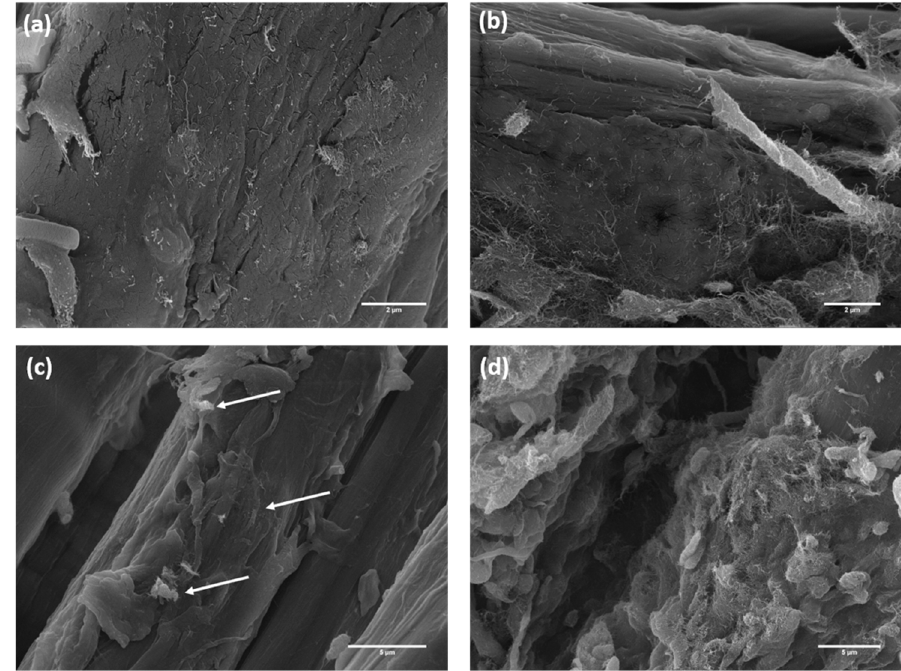
Figure 2. SEM micrographs showing the flax fabrics decorated with carbon nanotubes (CNTs) at different magnifications .